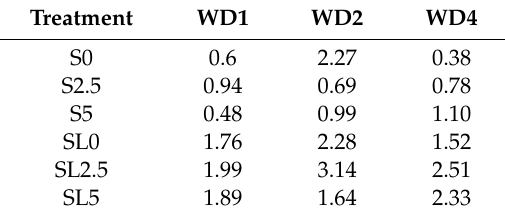
Table 4. Effect of wetting and drying (WD) cycles for the repellency index, RI , of the sandy (S) and sandy loam (SL) treatments.